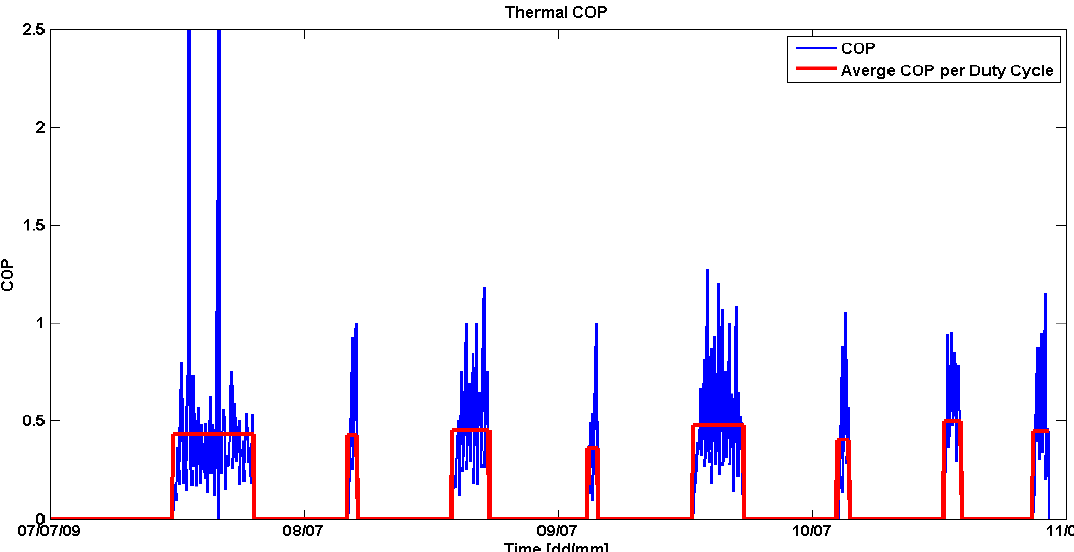
Figure 14. Coefficient of Performance ( COP ) on a sample ‐ by ‐ sample base and in average over the On ‐ state of a duty cycle.